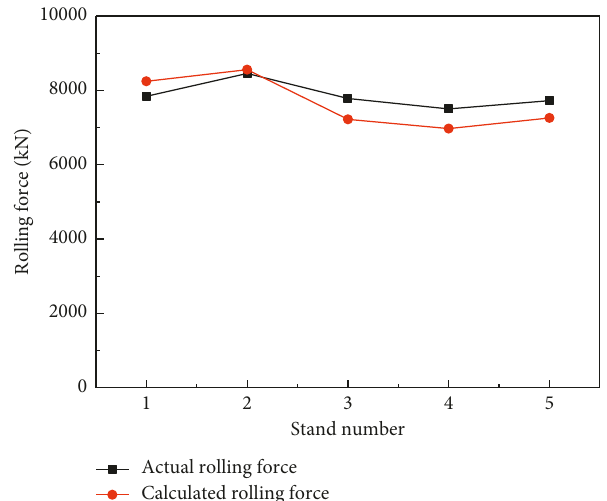
Figure 3: Comparison between the actual rolling force and calculated rolling